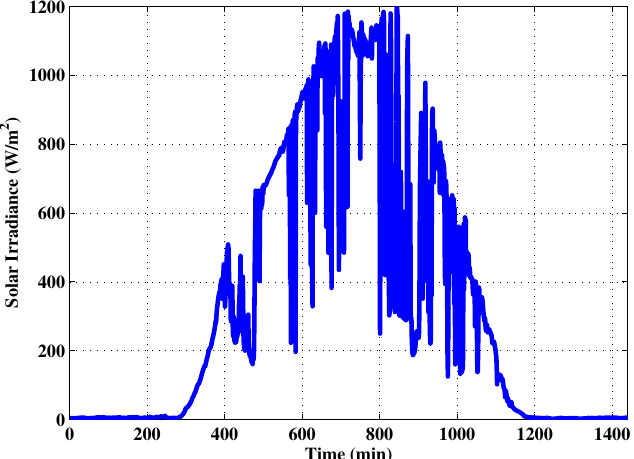
Figure 2. Solar irradiance measured each minute on 1 June 2012.